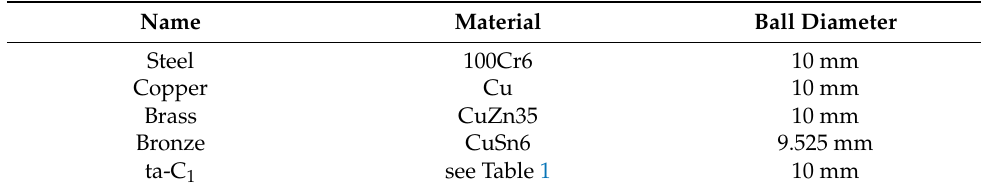
Table 2. Overview of tested balls used as counter bodies with their respective material composition and ball